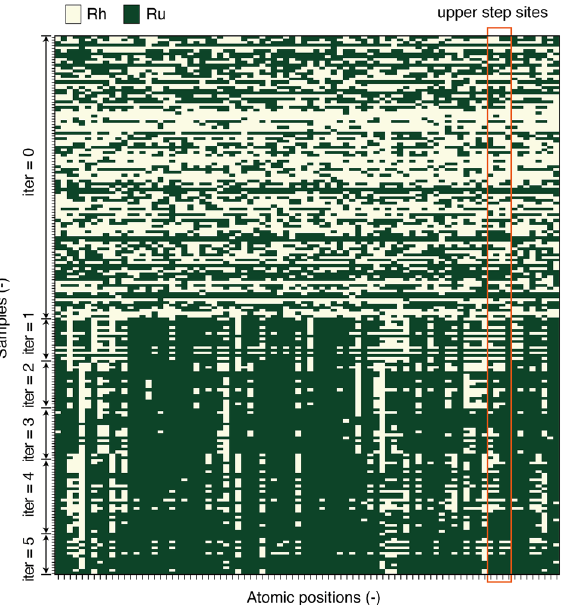
Figure 4. Distribution of Ru and Rh atoms in the initial (iter = 0) and the GAN-generated (iter = 1–5) surfaces. The white and green squares indicate the Rh and Ru atoms, respectively.